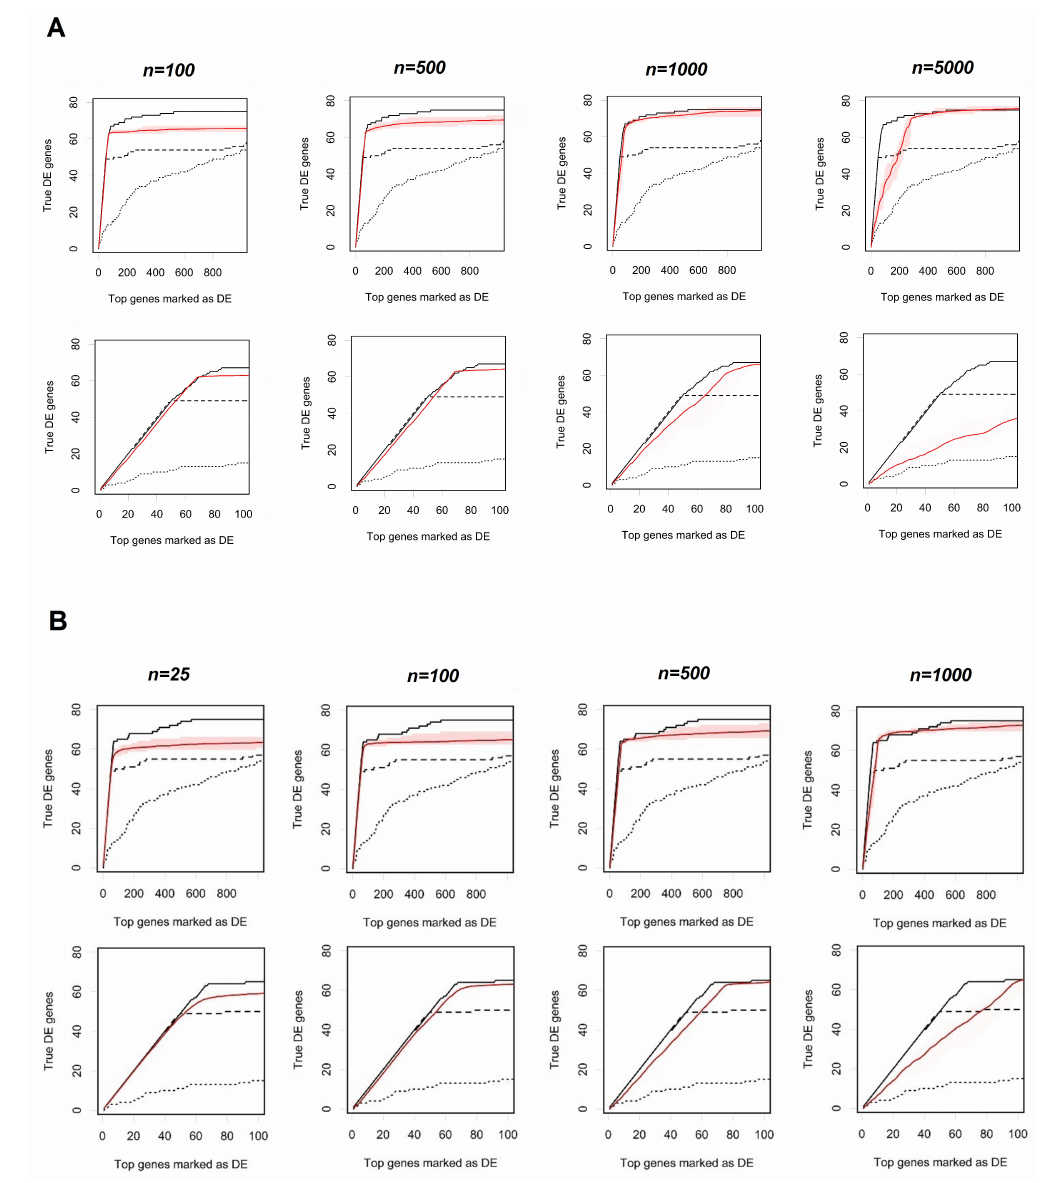
Figure S1. Performance of R-EBSeq Against Other Methods as a Function of th Number of Replicates. In all panels, the thick black line is Cuffdiff, the solid red is R-EBSeq, the large dashed black line is DESeq and the samll dashed black line is Bayseq. The number of replicates for each plot is indicated by the value for n above the graph. In each panel, the bottom row (top 100 ) is zoomed-in version of the top row (top 1,000). ( A ) Performance in the case of noise-free data; ( B ) Performance in the case of overdispersed, noise augmented